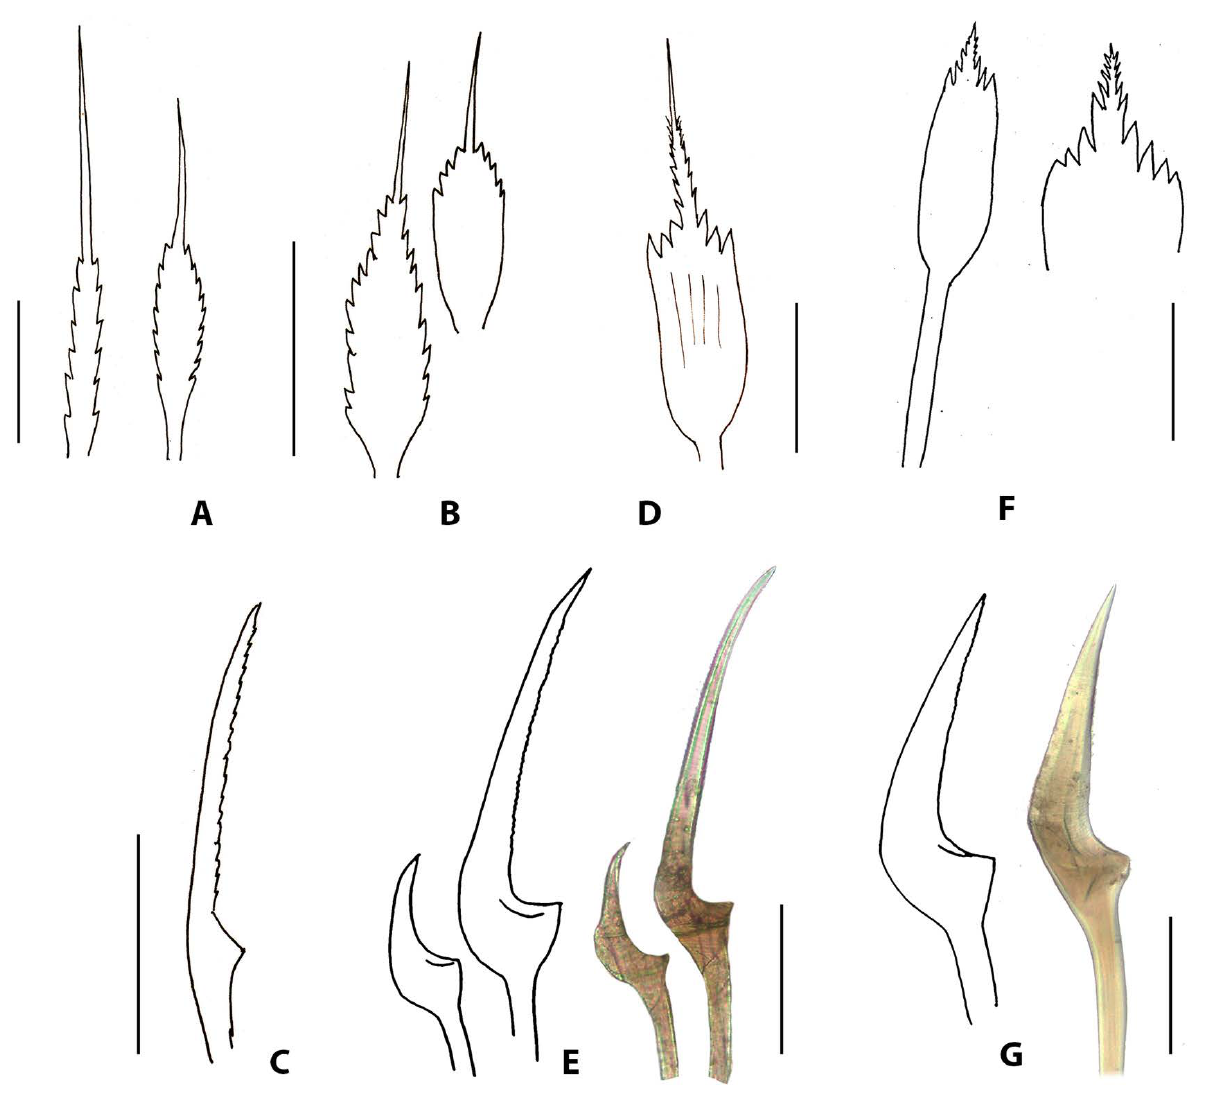
Fig. 12. – Sabellaria spinulosa. Changes in paleae morphology during growth: A, outer palea from a recently metamorphosed specimen (scale bar 20 m m); B-C, outer and middle paleae of a specimen 15 days after metamorphosis (scale bar 100 m m); D-E, outer and middle paleae in a specimen 40 days after metamorphosis (scale bar 150 m m); F-G, outer and middle paleae in a specimen 4 months after metamorphosis (scale bar 300 m